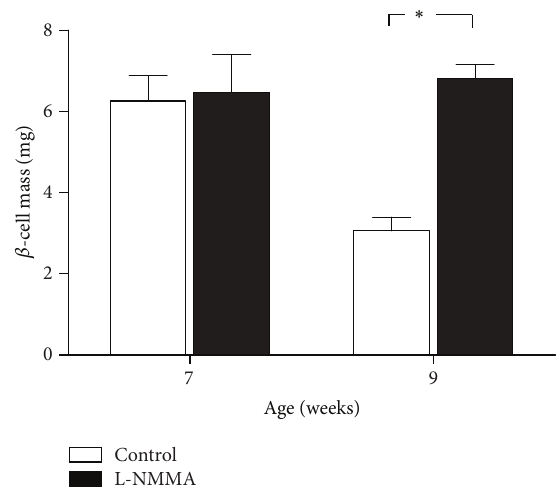
Figure 7: 𝛽 -cell mass was determined in pancreatic sections from BB rats treated with vehicle (white bars) or L-NMMA (black bars) at 7 and 9 weeks of age. 𝛽 -cell mass is presented in the bar graph as means ± SEM of values calculated as the ratio of insulin-positive area/total pancreatic area multiplied by the total pancreatic weight. Values are obtained from a mean of 5 animals. ∗ 𝑃 < 0.05 treated versus control.